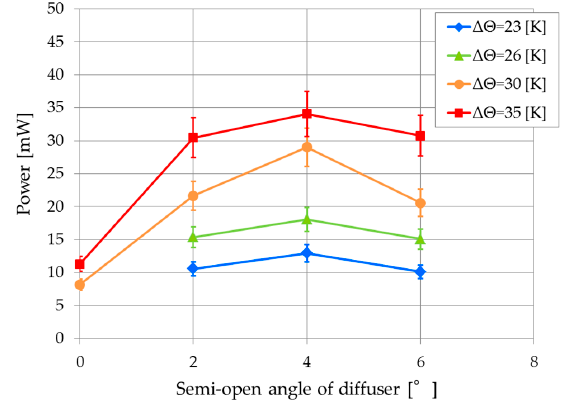
Figure 8. Power output P turbine vs. semi-open angle of diffuser model with tower height 2 m, for each temperature difference ∆ Θ = 23 to 35 K.